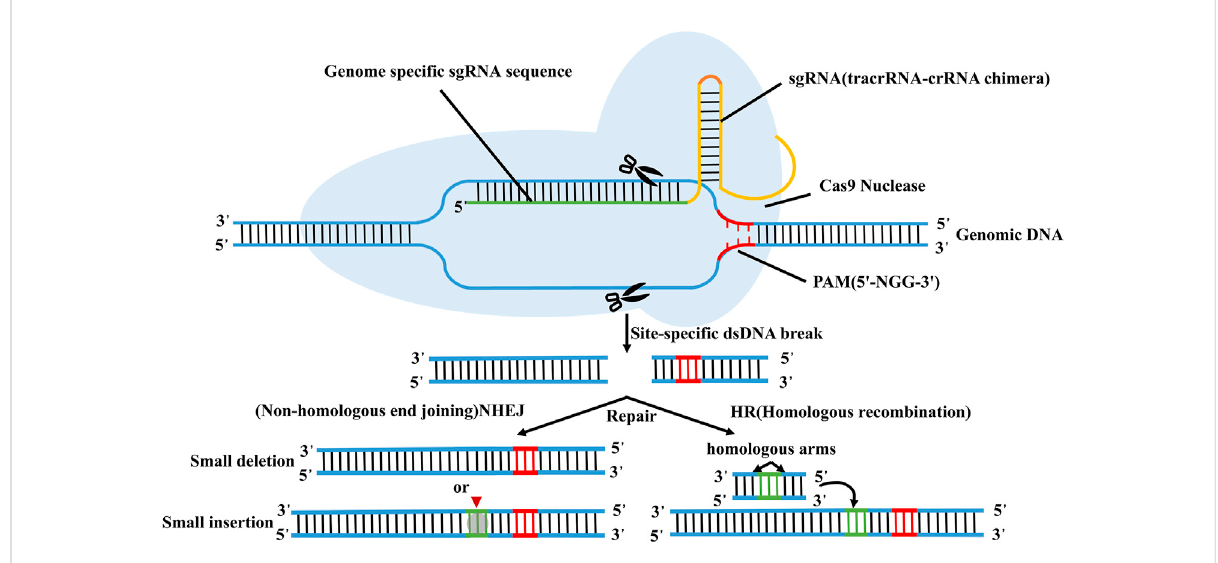
FIGURE 3 Schematic diagram of CRISPR/Cas9 technology. According to the dimer structure of crRNA and tracrRNA, a new single-stranded chimeric sgRNA (single guide RNA) can be designed to speci fi cally identify the target gene sequence, and then further combined with Cas9 protein to form a targeted cutting complex which speci fi cally cut the target DNA and break the double strand of